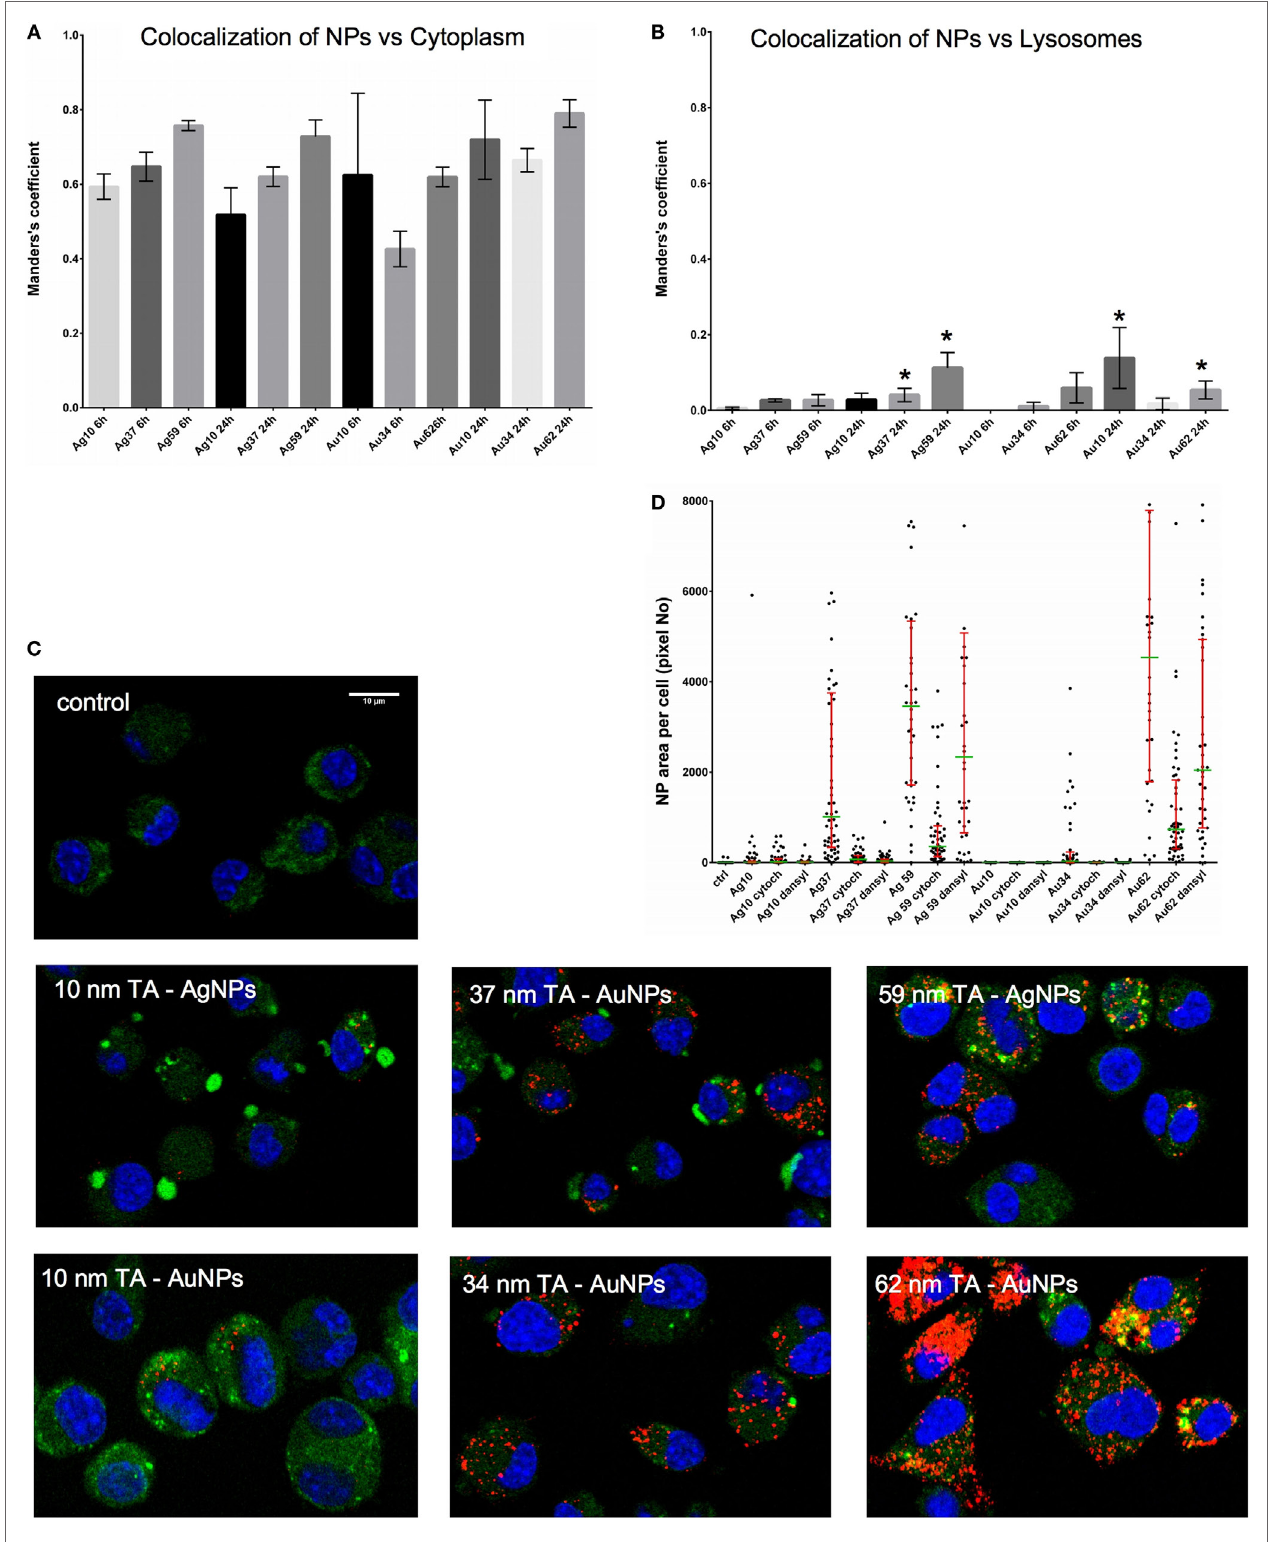
FigUre 5 | Intracellular localization of TA-Ag/AuNPs. The Manders’ coefficients for co-localization of TA-Ag/AuNPs and cytoplasm (a) or lysosomes (b) in JAWS II cell culture exposed to 10 nm, 37 nm, 59 nm TA-AgNPs and 10 nm, 34 nm, 62 nm TA-AuNPs for 24 h at 2.5 µg/ml. *Significant differences with p ≤ 0.05. (c) Representative images for lysosomes (green), nanoparticles (NPs) (red) and nuclei (blue) in cells exposed to NPs, as described above. (D) NPs content in cells subjected to pretreatment with 10 µg/ml monodansyl cadeverine and 5 µg/ml cytochalasin D, and then to incubation with TA-Ag/AuNPs at 2.5 µg/ml for 6 h.